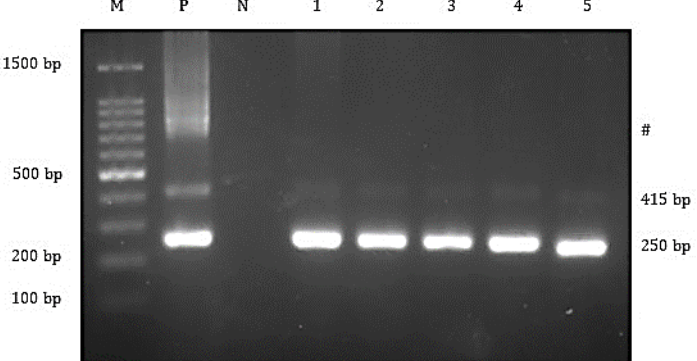
Figure 2. Agarose gel electrophoresis showing the 415 and 250 bp bands of the TiLV genes from the affected fish. Lane M = 1 kb DNA marker; Lane P = positive control; Lane N = negative control; Lane 1 to 5 = All TiLV-positive samples yielded 415 and 250 bp amplicons. #Marks band are from cross-hybridizations between amplified products.